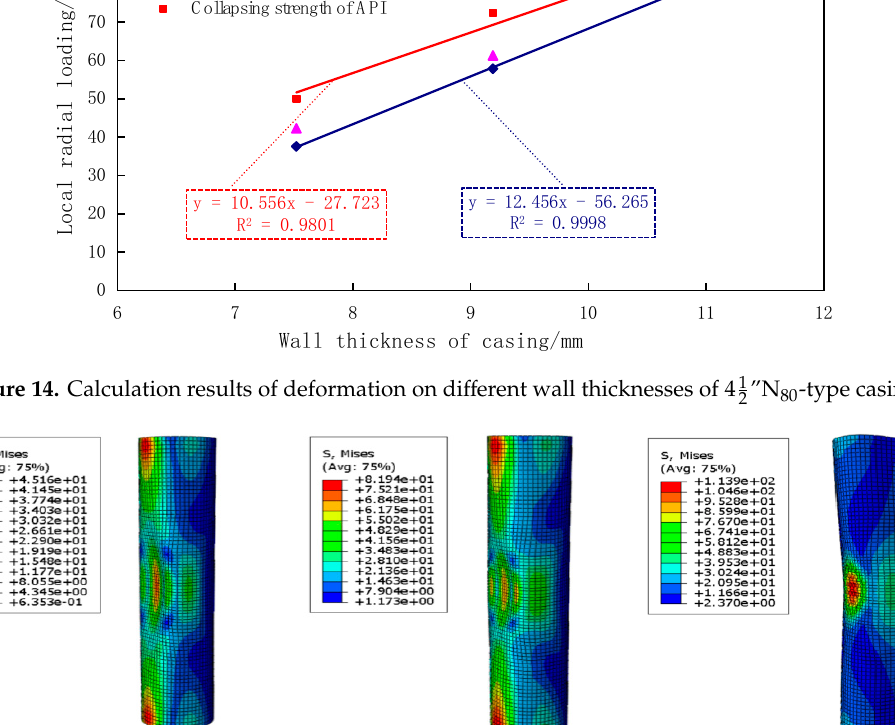
Figure 15. Finite element deformation simulation on different casing wall thicknesses.